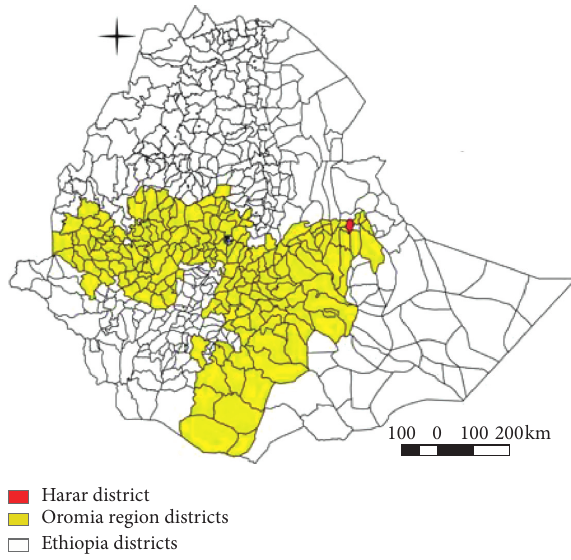
Figure 1: Map of study site (produced using QGIS